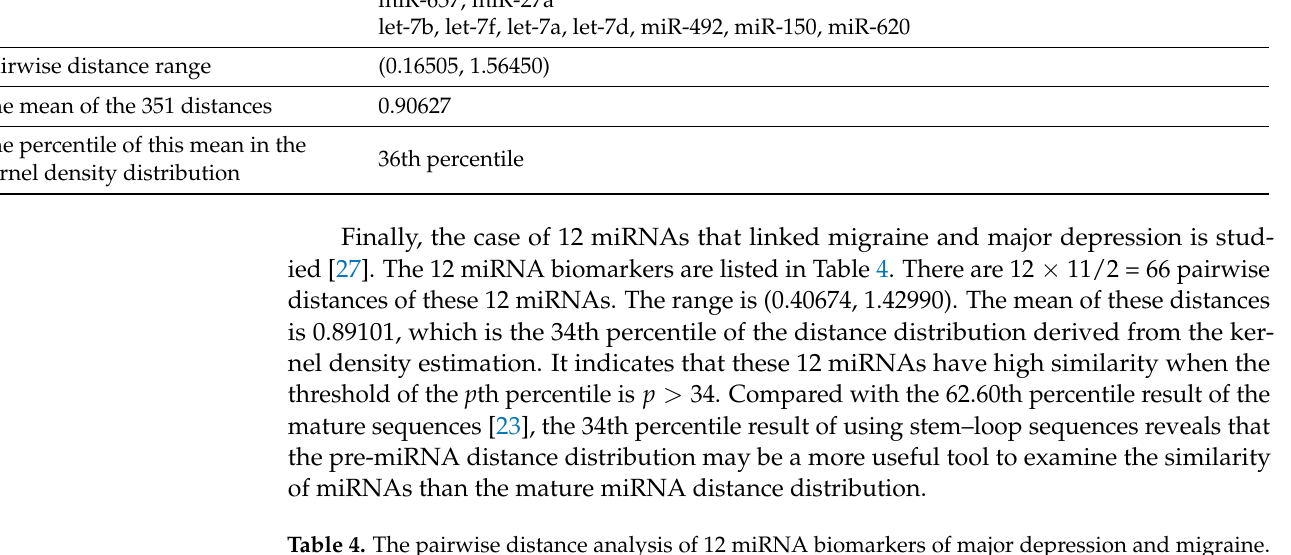
Table 4. The pairwise distance analysis of 12 miRNA biomarkers of major depression and